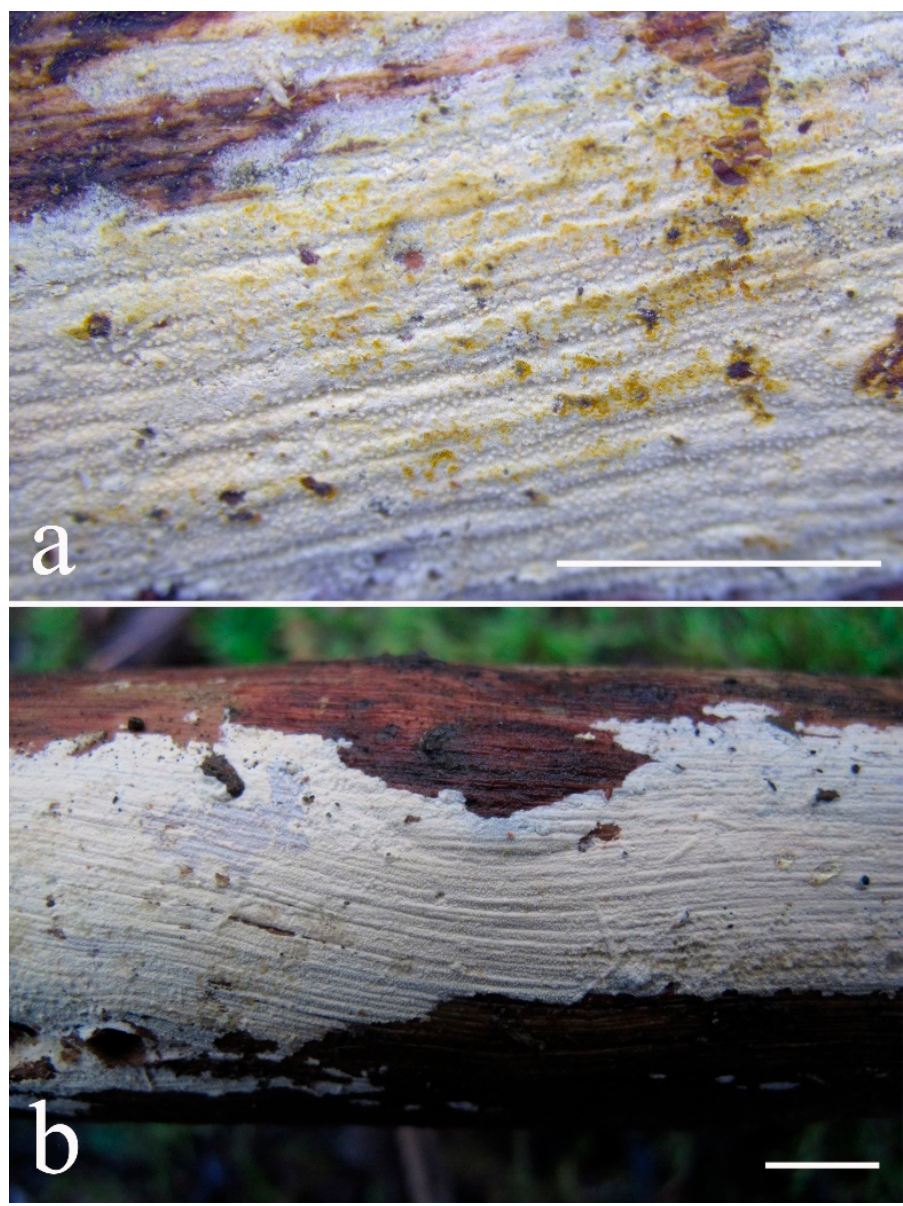
Figure 20. Basidiocarps of Xylodon acystidiatus (LWZ 20180514-9, holotype).—Scale bars: a = 5 mm; b = 1 cm.